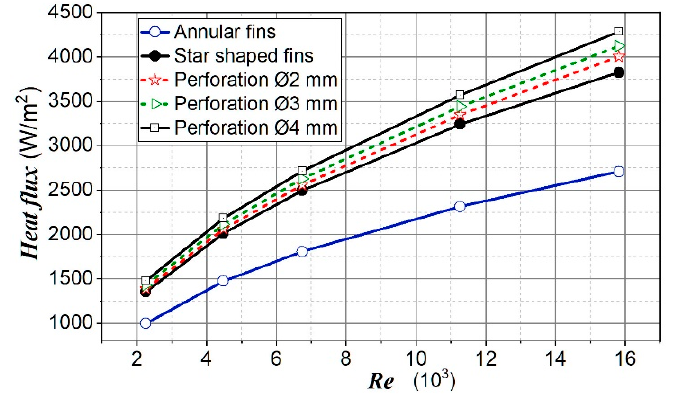
Figure 15. Heat flux for analyzed cases.